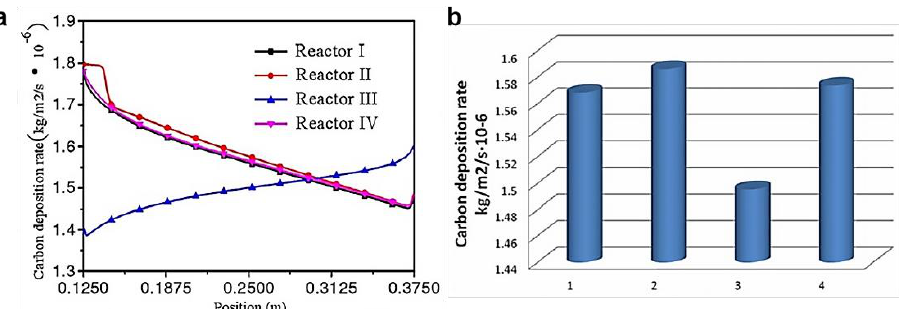
Figure 24. ( a ) Carbon deposition rates in four different structural reactors; ( b ) average carbon deposition rates in four different reactors [193].